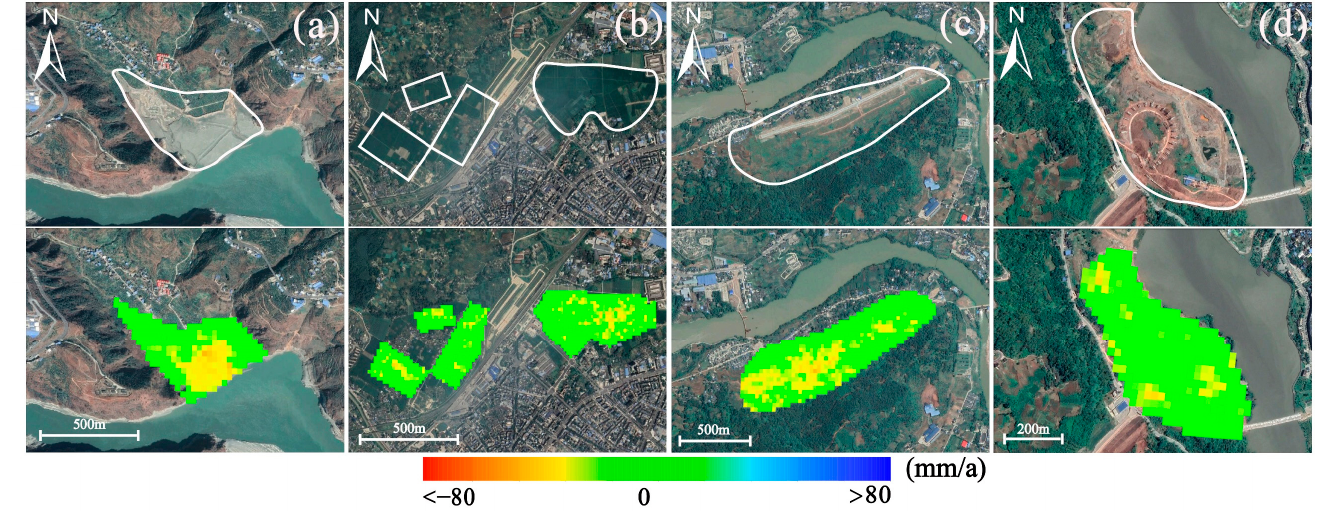
Figure 11. Exemplar areas in motion with misclassified landslides: (a) alluvial fan, (b) agricultural irrigation, (c) ground subsidence, and (d) human engineering activities.